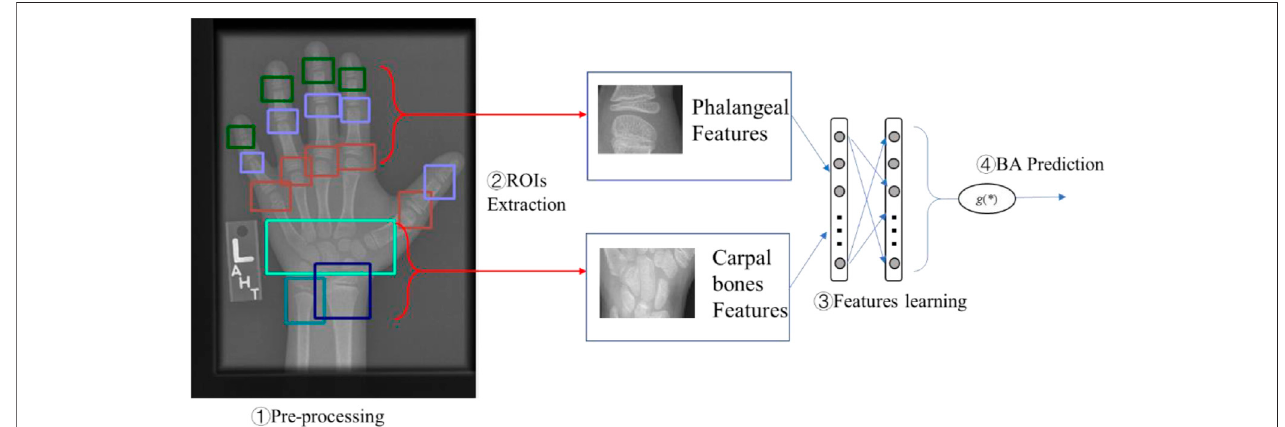
FIGURE 1 | Framework of the proposed new BAA